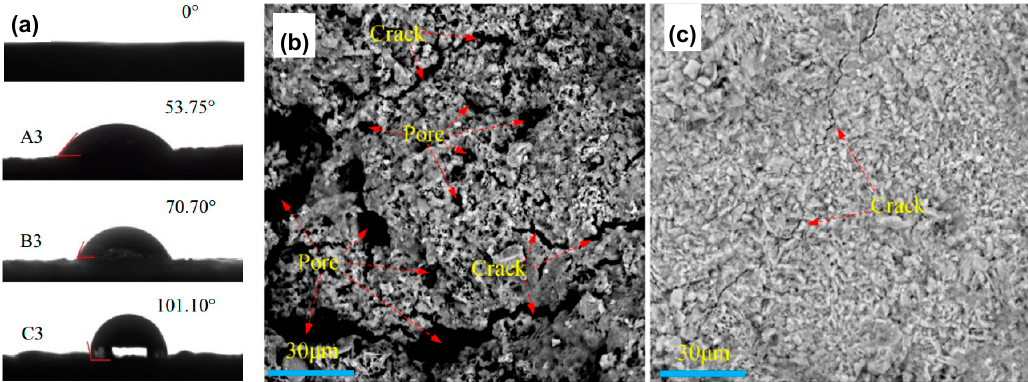
Figure 12. ( a ) Water static contact angles of samples before (0°) and after treatment (A3, B3, C3). SEM images of ancient tiles ( b ) before and ( c ) after MICP treatments. Adapted with permission from [87] 2020, Elsevier.